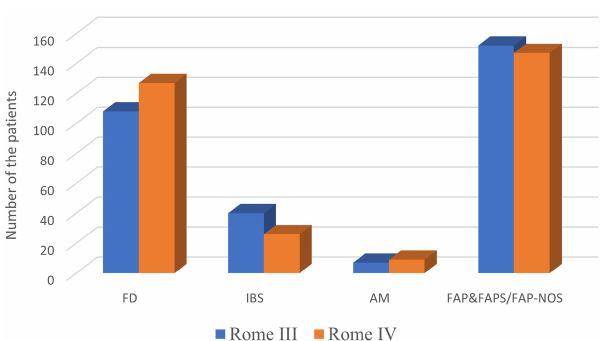
FGIDs, functional gastrointestinal disorders; FD, functional dyspepsia; IBS, irritable bowel syndrome; AM, abdominal migraine; FAP, functional abdominal pain; FAPS, functional abdominal pain syndrome; FAP-NOS, functional abdominal pain not otherwise specified.